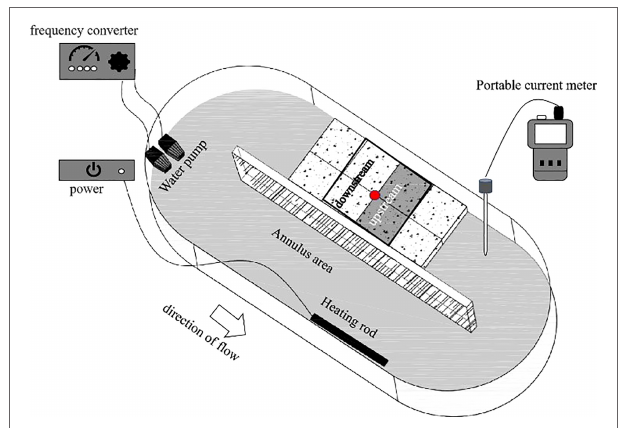
FIGURE 1 | The tank used in the water flow experiment. The red dot is the starting point of the sea